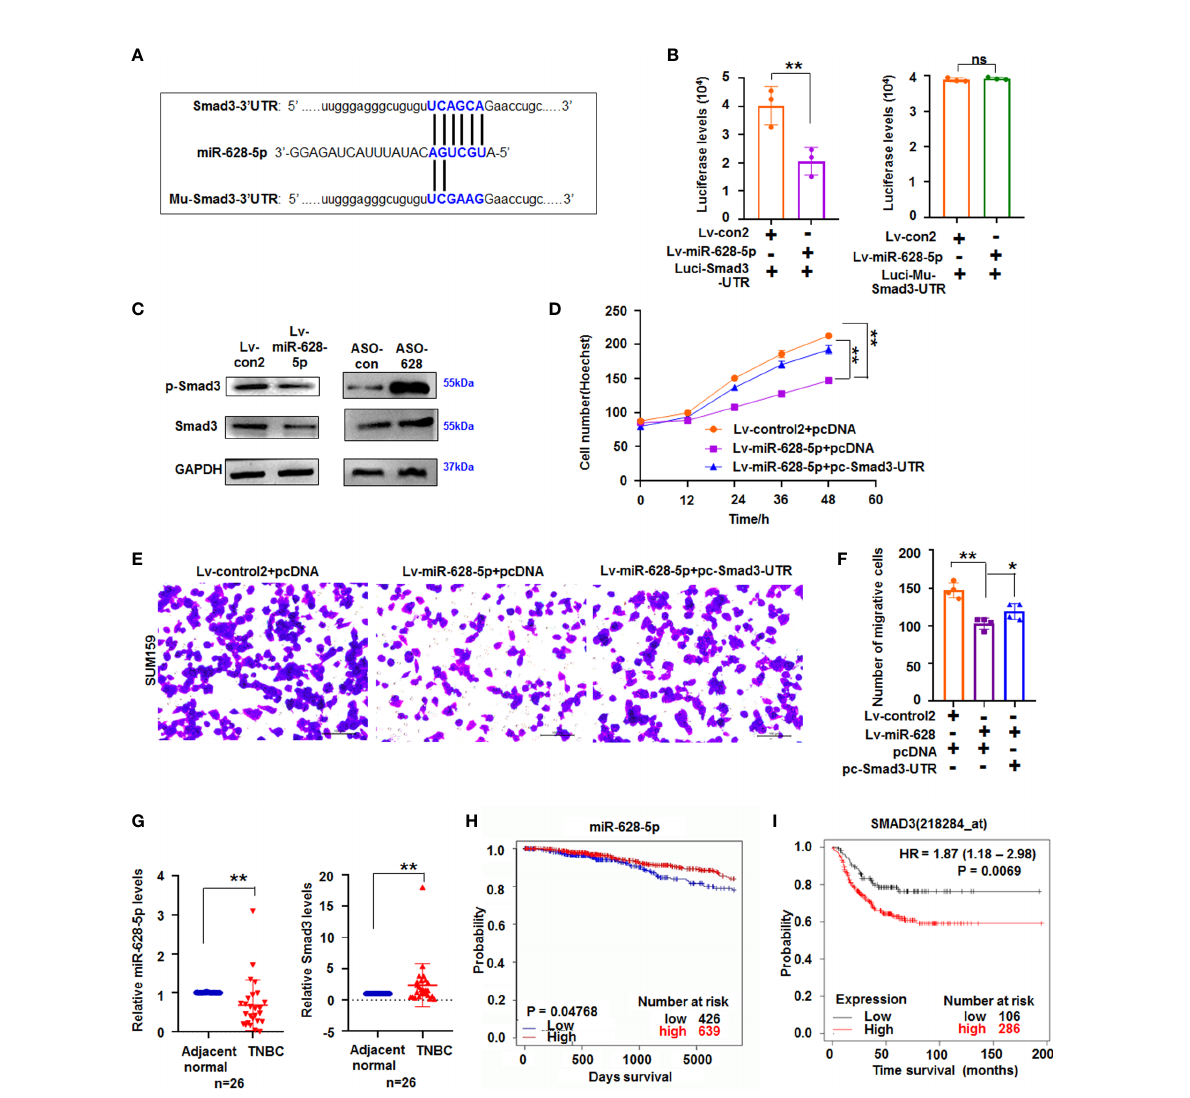
FIGURE 4 miR-628-5p regulated Smad3 expression. (A) The site of Smad3-3 ’ UTR or Mu-Smad3-3 ’ UTR targeted by miR-628-5p. (B) Luciferase levels were analyzed in pc3.1-luci-Smad3-3 ʹ UTR and miR-628-5p-treated cells. Data are expressed as the mean ± SD of triplicate experiments. ** p < 0.01, Student ’ s t-test. ns means “ no signi fi cance ” . (C) immunoblotting detection. (D) Effect Smad3-3 ′ UTR treatment on the role of miR-628-5p in SUM159 cell growth using Hoechst staining assay. Data are expressed as the mean ± SD of triplicate experiments. * p < 0.05, ** p < 0.01; ANOVA. (E, F) Effect of Smad3-3 ′ UTR treatment on the role of miR-628-5p in regulating SUM159 cell metastasis. Data are expressed as the mean ± SD of triplicate experiments. ** p < 0.01; ANOVA. (G) Expression of miR-628-5p and Smad3 in TNBC tissues (n=26) was analyzed by qRT-PCR.